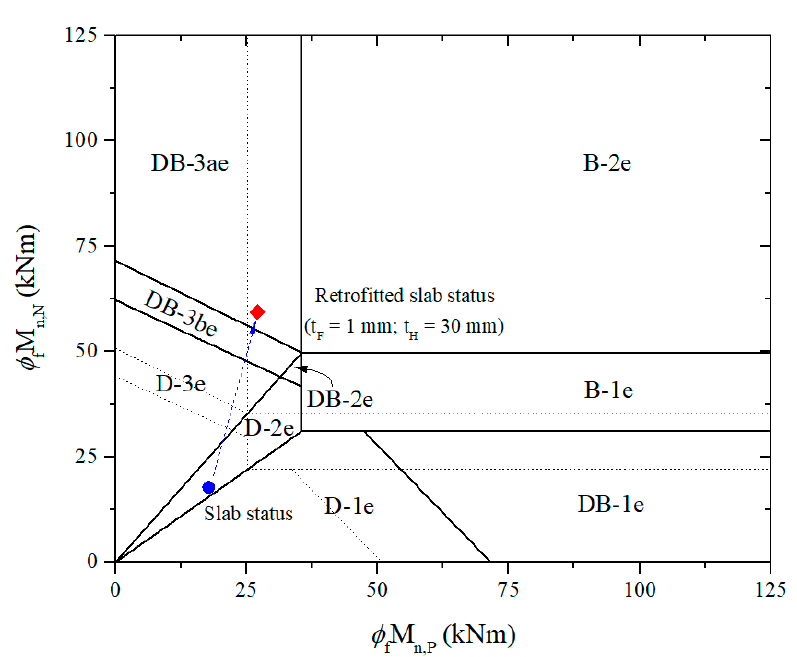
Figure 9. Establish failure limits and predict slab status based on moment carrying capacities for the retrofitted slab.